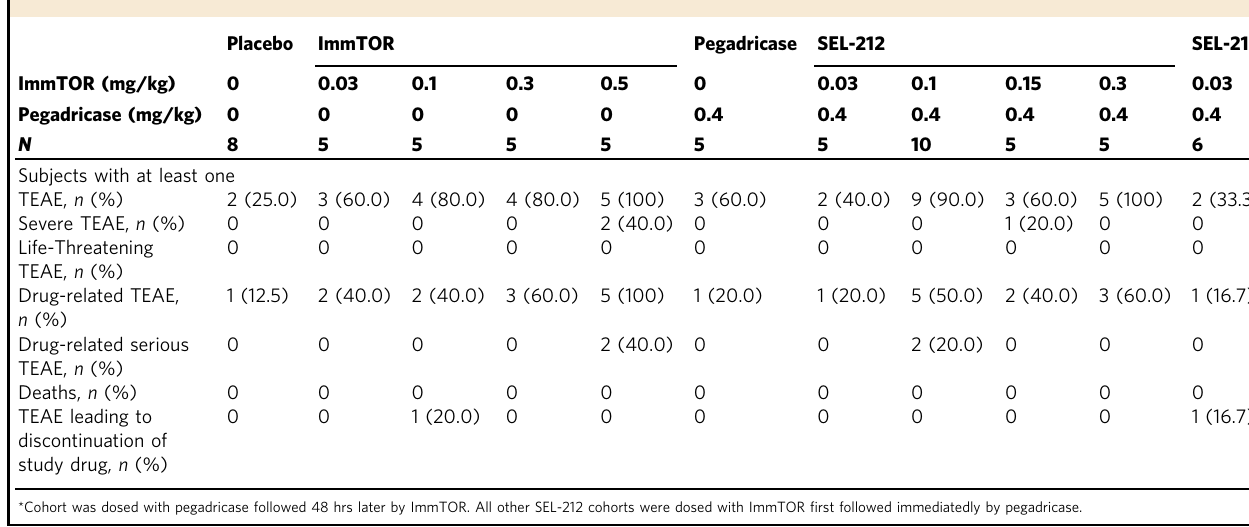
Table 1 Phase 1b Treatment Emergent Adverse Events.